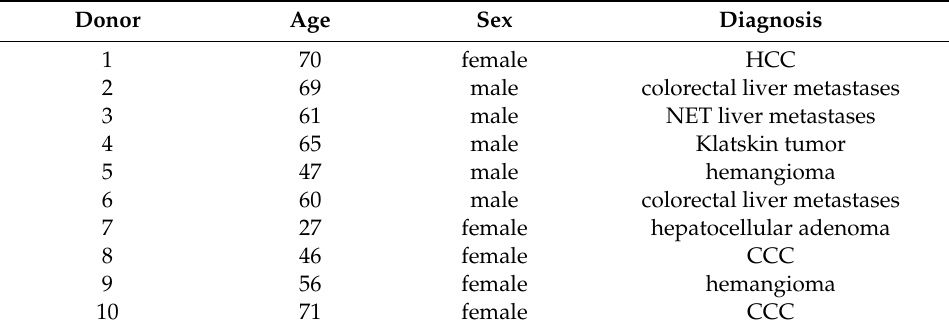
Table 1. Donor specifications. List of donor number, age, sex, and diagnosis.